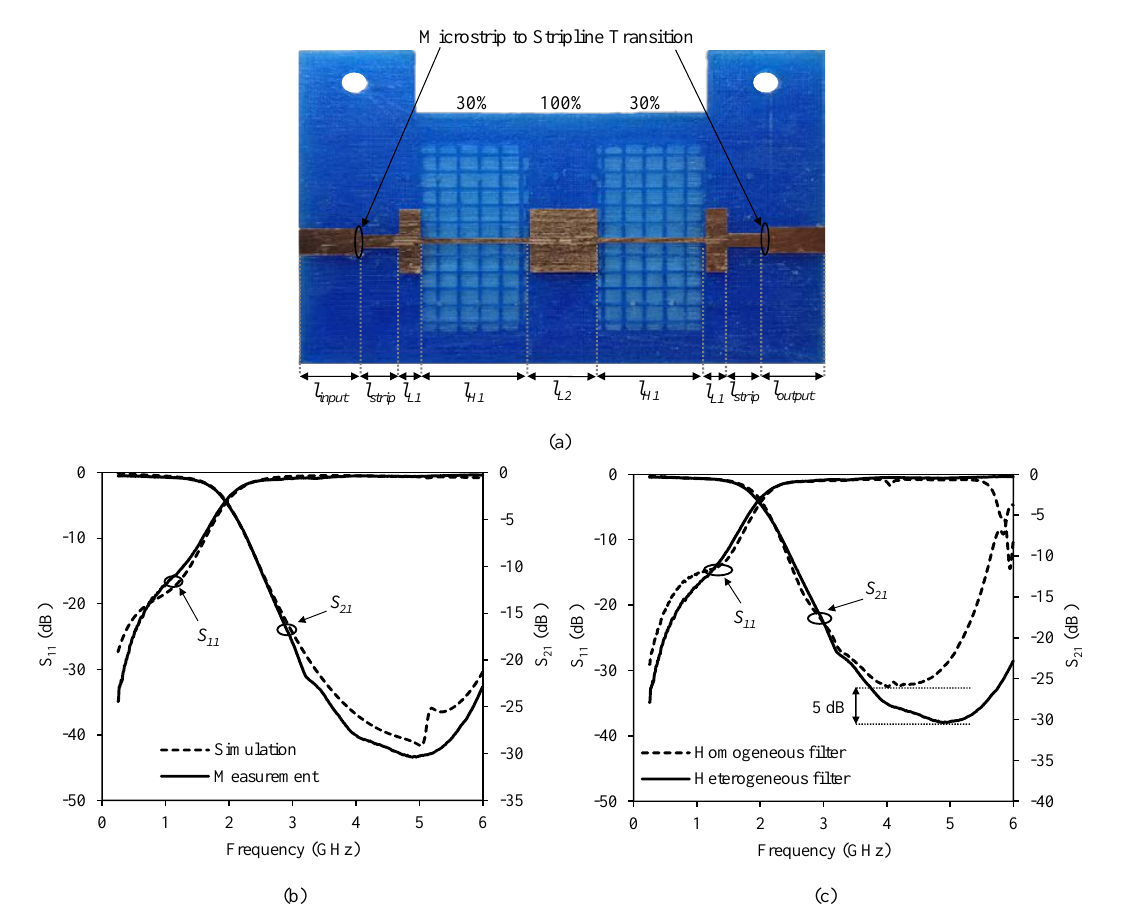
Figure 14. ( a ) Stepped impedance filter manufactured with different densities before its implementation is completed. ( b ) Measured and simulated response of the stepped impedance filter with different densities. ( c ) Comparison measurements of the different filters.